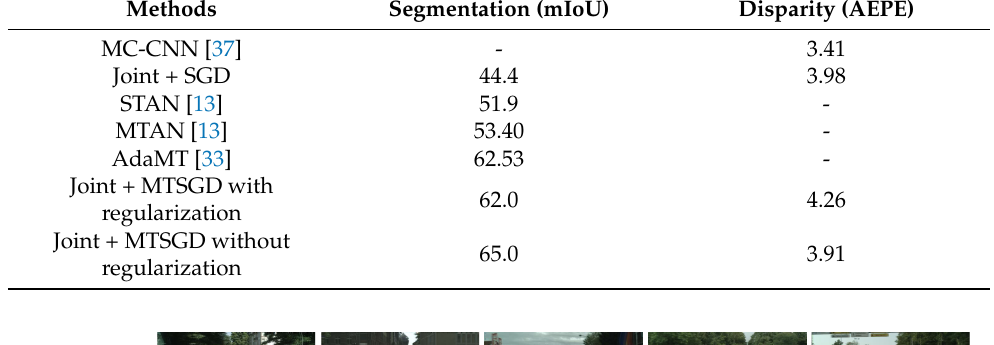
Table 1. Performance comparison with representative methods. ’Joint + SGD’ denotes the joint learning of semantic segmentation and disparity estimation with the original SGD algorithm, ’Joint + MTSGD with regularization’ denotes the model that is trained with our proposed MTSGD optimization algorithm and L2 regularization, and ’Joint + MTSGD without regularization’ de- notes the model that is trained with our proposed MTSGD optimization algorithm but without L2 regularization.